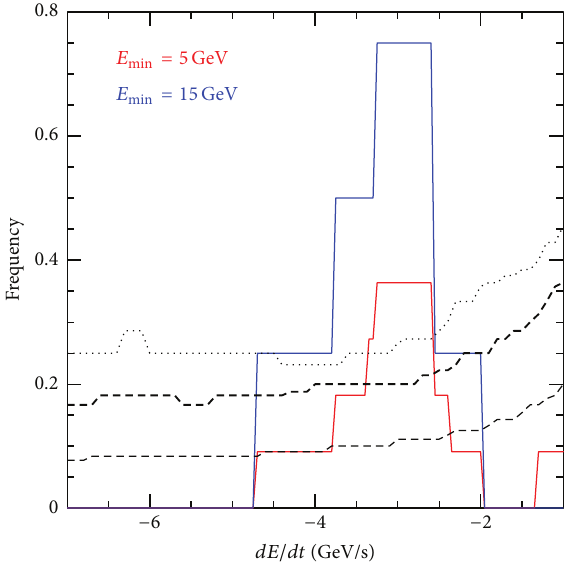
Figure 7: Here shown are the results of a study of the type already described in Figure 5, but now restricting the analysis to the time interval from 190 seconds to 640 seconds after the trigger. Dotted/dashed lines represent again the 10 %, 1 %, and 0.23 % probability that the given frequency of occurrence of spectral lags is a chance occurrence.